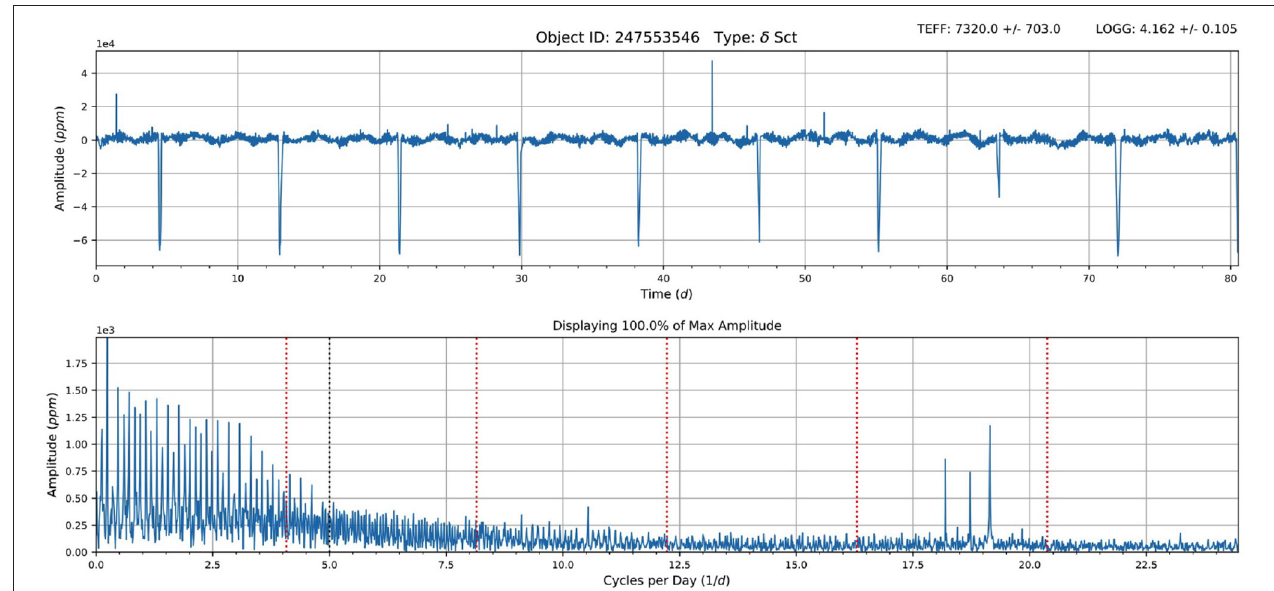
FIGURE 9 | The light curve (Top) and amplitude spectrum (Bottom) of δ Sct candidate in an eclipsing binary, EPIC 247553546, observed during C13.